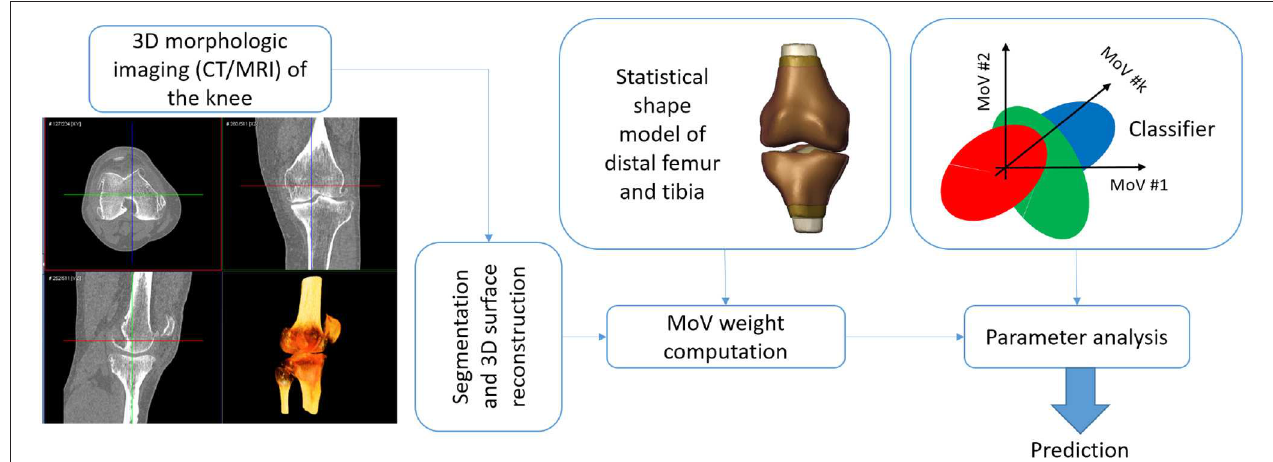
FIGURE 6 | The application